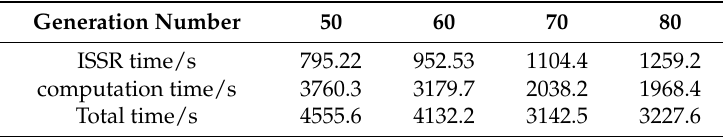
Table 1. The computational time under different generation numbers.